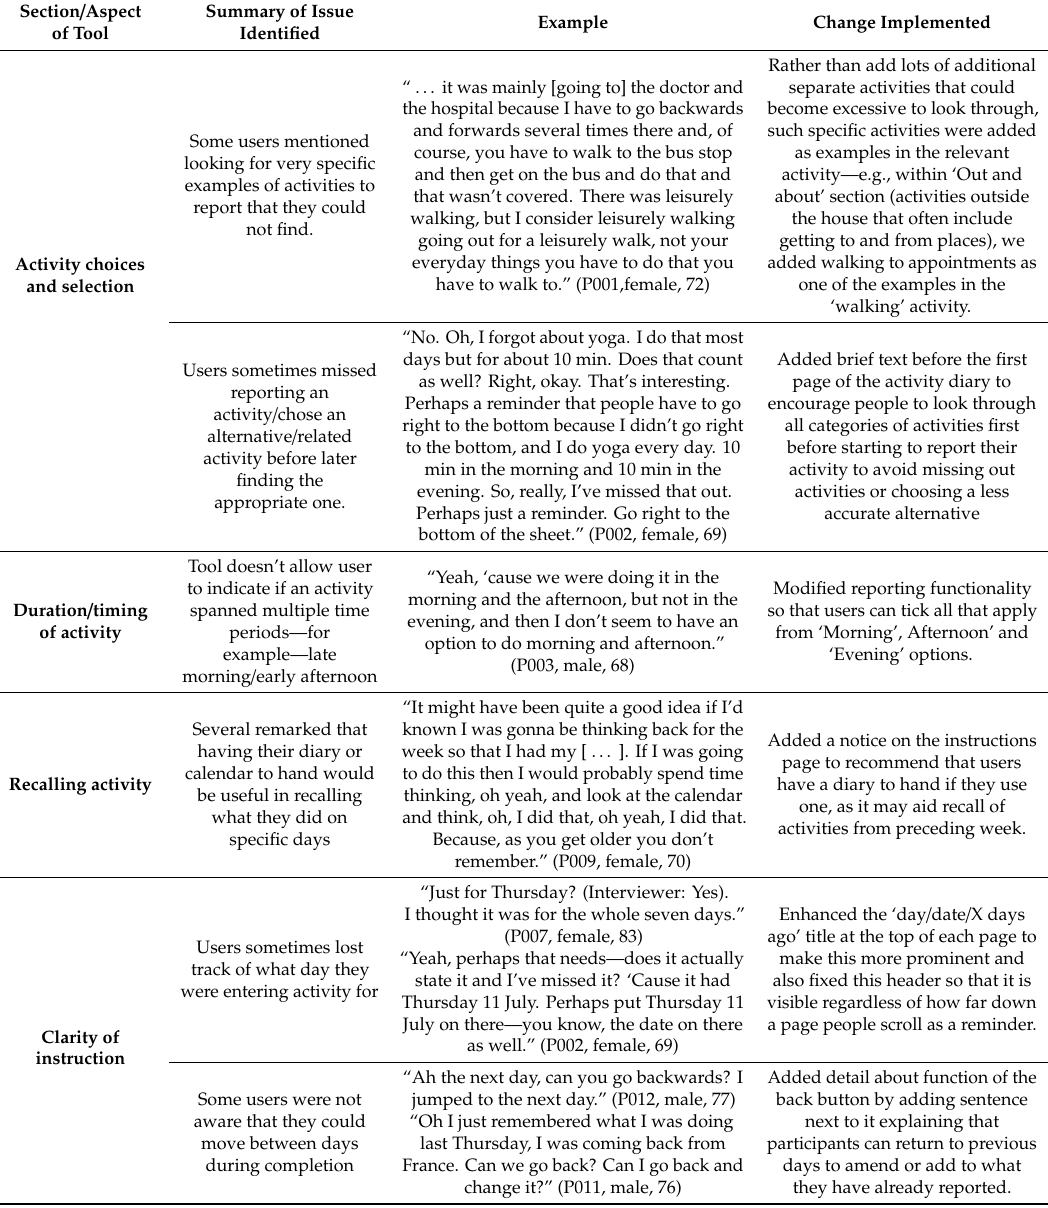
Table 5. Key issues arising from think-aloud interviews and changes